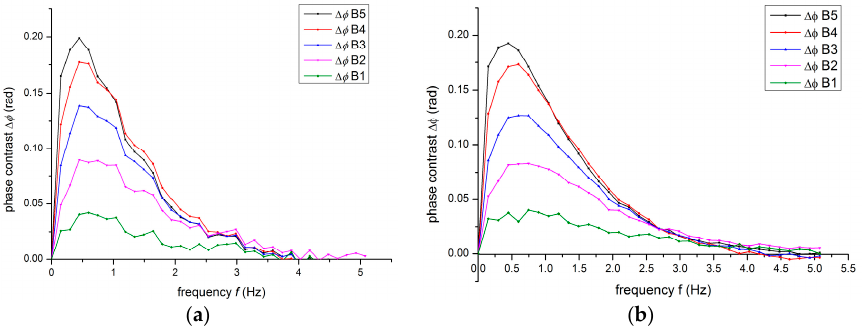
Figure 10. Phase contrast profiles of the Series B insertions (0.4 mm) after: ( a ) selecting the left top corner; and ( b ) the whole surface as a sound area.